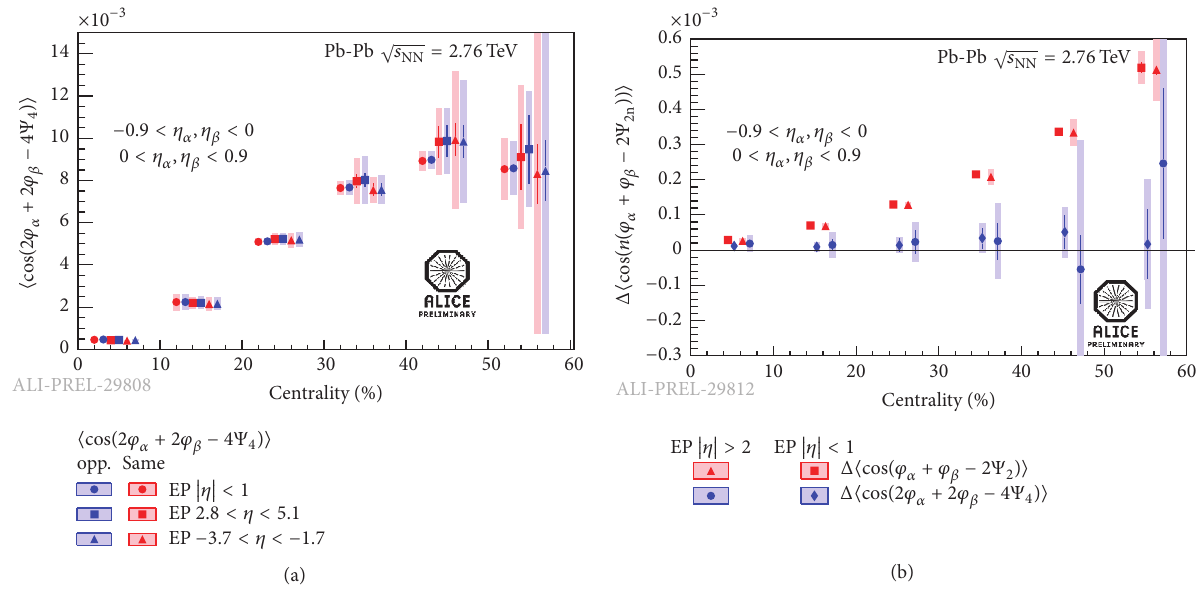
Figure 11: (a) Same-charge and opposite-charge pair correlations relative to the 4th harmonic event plane as functions of centrality. (b) Comparison of the charge-dependent parts in correlations with respect to the 2nd and 4th harmonic event planes [79].